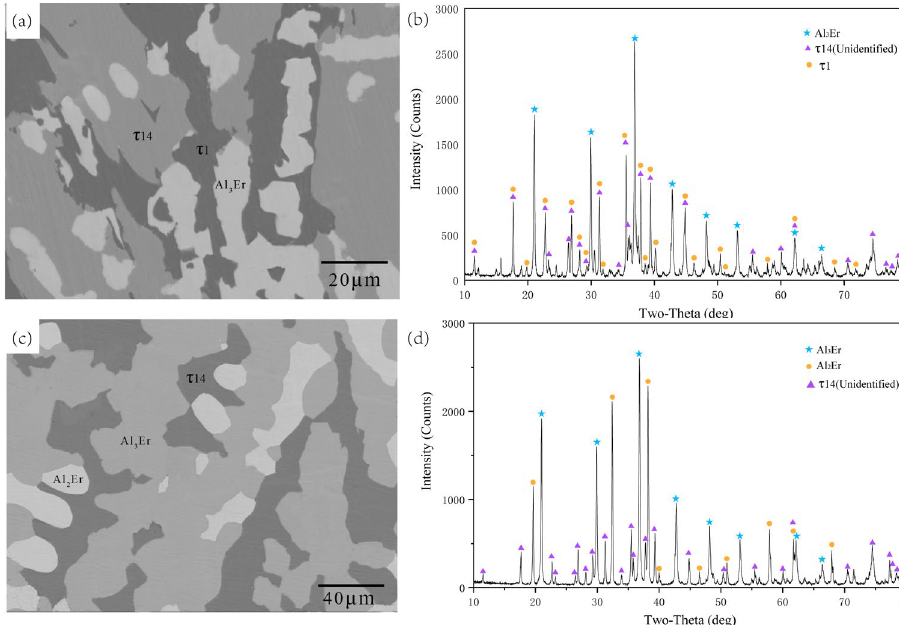
Figure 6. BSE micrographs and XRD patterns of alloys: ( a , b ) A7; ( c , d ) A8. The BSE images of Alloy Samples A1, A2, A4, and A6 are displayed in Figure 7, with Figure 7a showing three distinct contrasts. The black phase was Al, the medium gray phase was Al 3 Ni, and the light gray phase was τ 2(Al 9 Ni 3 Er). Similarly, Figure 7b shows three distinct contrasts. The black phase was Al, the light gray phase was Al 3 Er, and the medium gray phase was τ 1(Al 19 Ni 5 Er 3 ). Figure 7c shows that each phase area had clear edges. The dark gray phase was Al 3 Ni, the medium gray phase was Al 3 Ni 2 , and the light gray phase was τ 2(Al 9 Ni 3 Er). The light gray matrix phase in the BSE image (Figure 7d) of Alloy Sample A6 was the τ 1(Al 19 Ni 5 Er 3 ) compound, the light gray phase was τ 2(Al 9 Ni 3 Er), and the black phase was Al.